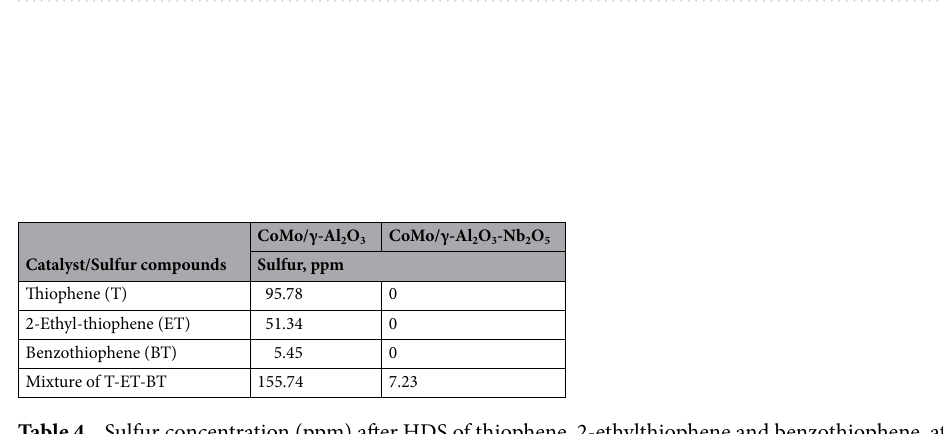
Figure 12. Product yields with temperature over CoMo/γ-Al 2 O 3 –Nb 2 O 5 ; ( A ) single thiophenic compound HDS (T, 2-ET, BT); ( B ) mixture of thiophenic compounds HDS (T + 2-ET + BT).